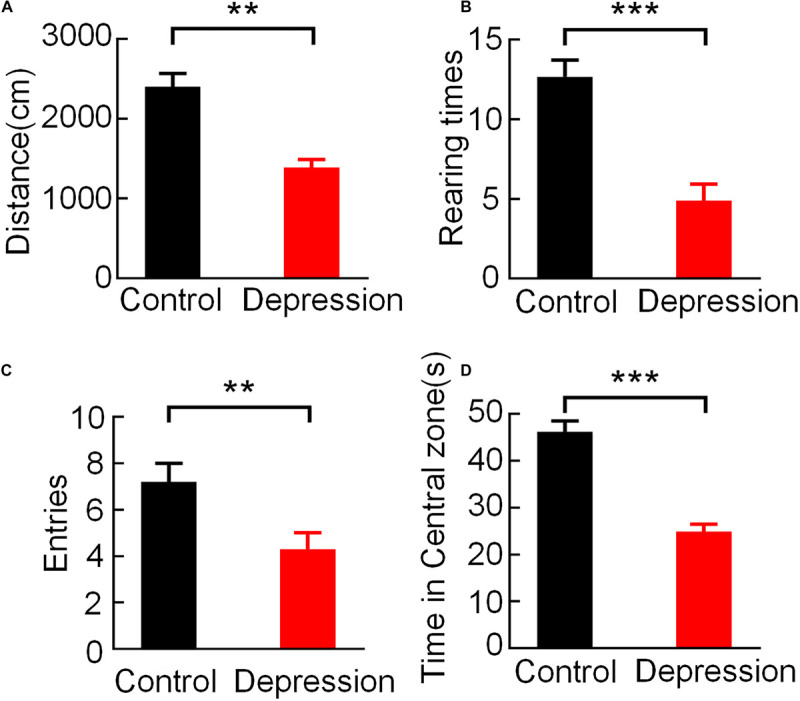
Comparison of behavioral performance in the OFT between the control and depression groups. (A) Comparison of the averaged movement distance. (B) Comparison of the averaged rearing times. (C) Comparison of the averaged entries of the central zone. (D) Comparison of the averaged time spent in the central zone. Error bars indicate SEM. Independent sample t-test, **p < 0.01, ***p < 0.001.